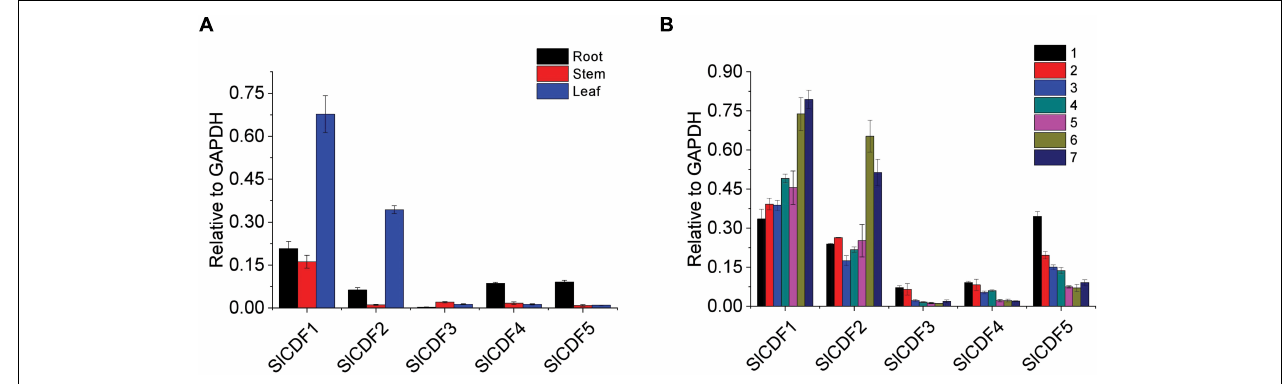
FIGURE 2 | Transcription analyses of tomato SlCDF1–5 throughout development and among tissues. (A) SlCDF1–5 expression levels in tomato roots, stems, and leaves at 5-weeks-old tomato plants. (B) SlCDF1–5 expression levels in the first seven individual leaves from top to bottom in 7-weeks-old tomato plants. Three technical replicates were performed for each extract, vertical bars on the lines represent the SE ( n = 3).